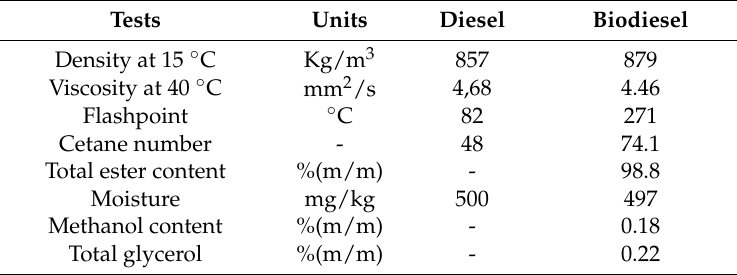
Table 1. Diesel and Palm biodiesel